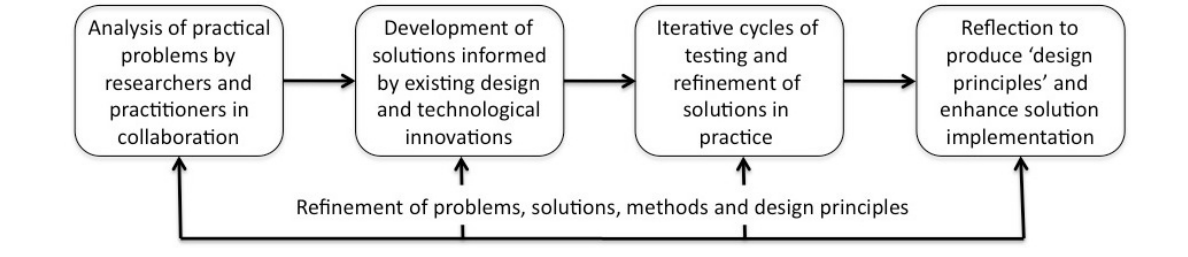
Stage 1: Development of SeeCare Ericsson